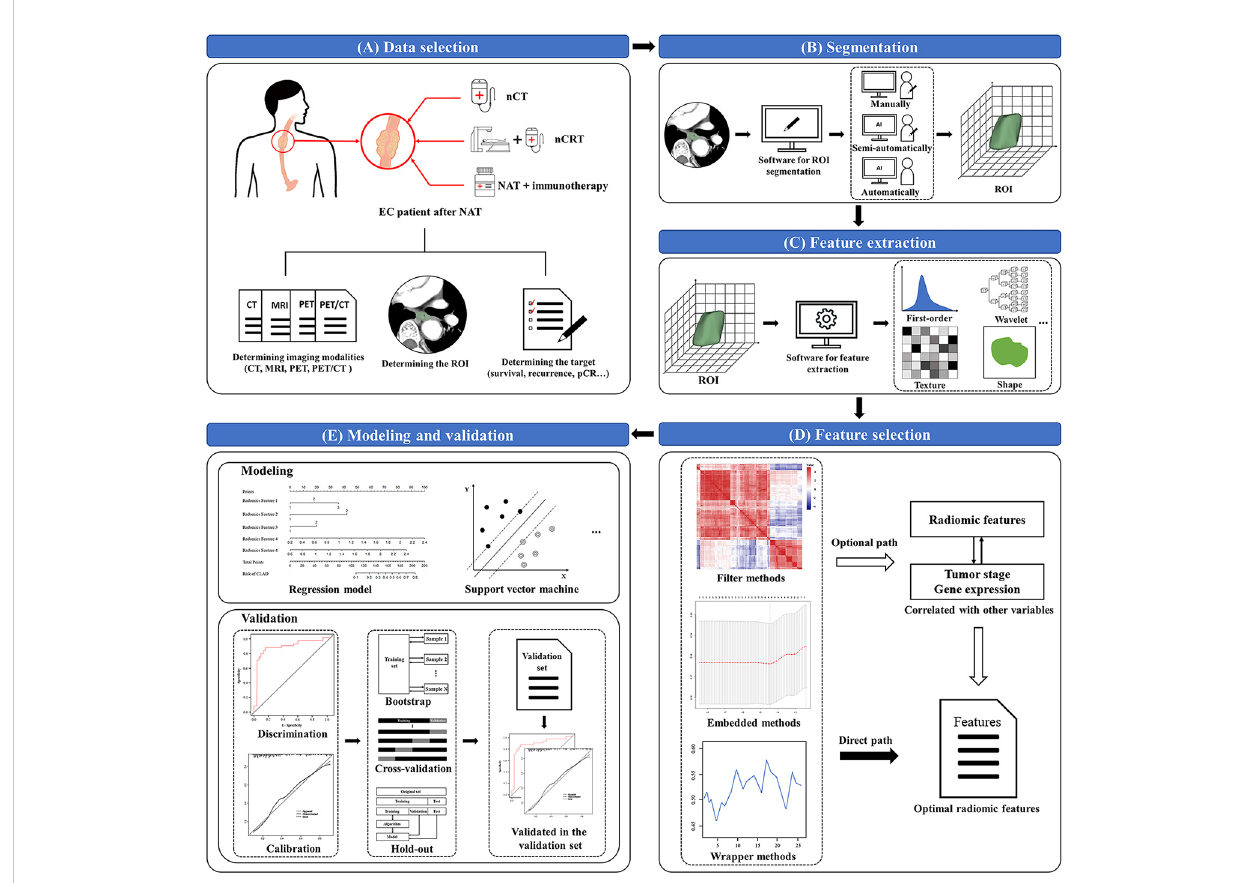
FIGURE 1 Work fl ow of radiomics. (A) Data selection: determines the imaging modalities, the tumor regions of interest (ROI), and a prediction target; (B) Segmentation: segments the delineated tumor ROIs in the original or processed images; (C) Feature extraction: extracts quantitative radiomic features through software or package from the tumor ROIs; (D) Feature selection: selects the extracted features by using the fi lter, embedded or wrapper methods; (E) Modeling and validation: models the selected radiomic features by speci fi c methods, then discriminates and calibrates through bootstrap, cross-validation or hold-out methods. EC, esophageal cancer; NAT, neoadjuvant therapy; nCT, neoadjuvant chemotherapy; nCRT, neoadjuvant chemoradiotherapy; ROI, regions of interest; pCR, pathological complete